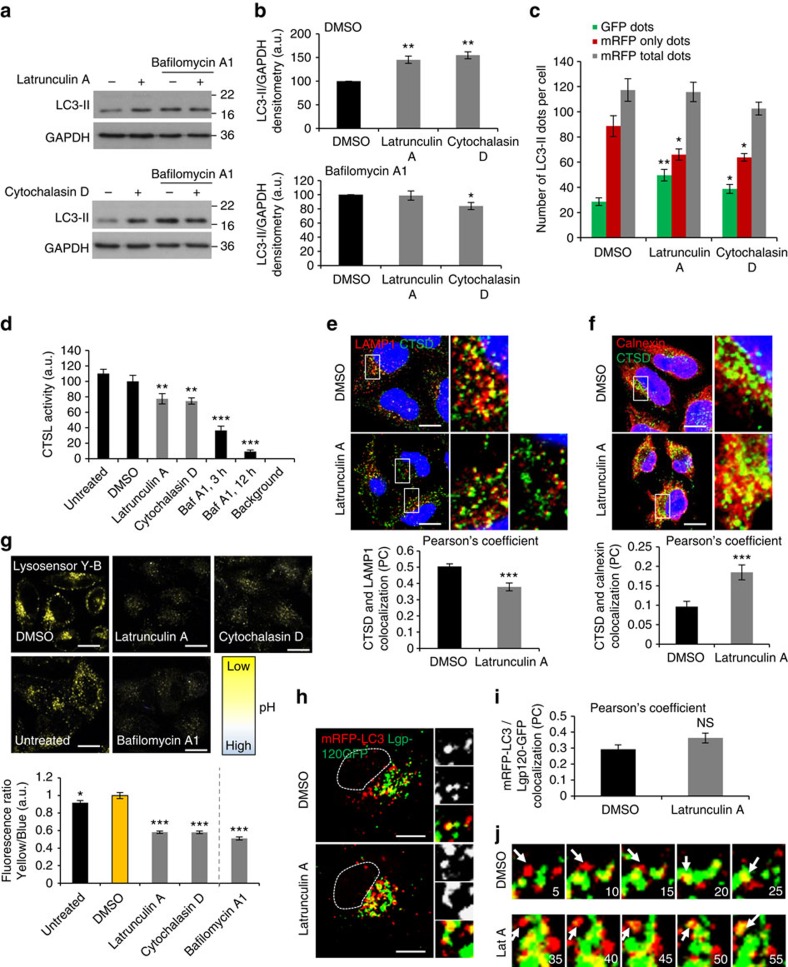
Depolymerization of actin cytoskeleton reduces the lysosomal biogenesis.(a) LC3-II levels in HeLa cells treated with latrunculin A (1 μM) or cytochalasin D (1 μM) for 3 h in the presence or absence of Bafilomycin A1 (400 nM, 3 h). (b) LC3-II/GAPDH densitometry in HeLa cells treated with Latrunculin A or Cytochalasin D as in a. Bars—means±s.d. (n=3; **P<0.01; *P<0.05; two-tailed one sample t-test). (c) GFP dot numbers (autophagosomes) and mRFP-only dots (autolysosomes) in HeLa cells stably expressing mRFP-GFP-LC3 and independently treated with 1 μM latrunculin A or cytochalasin D for 3 h. Graphs show the results for one representative experiment: eight wells of 100–200 cells each were analysed per sample. Experiment was repeated with similar results. Bars—means±s.e.m. (n=8; **P<0.01, *P<0.05; two-tailed t-test) (d) Cathepsin L (CTSL) activity in HeLa cells treated with the indicated drugs (1 μM, 3 h). Bafilomycin was positive control (400 nM, 3 h). Bars—means±s.d. (n=3; ***P<0.001, **P<0.01; two-tailed t-test). (e) Cathepsin D (CTSD, anti-mouse Alexa 488) and LAMP1 (anti-rabbit Alexa 568) double-immunostaining in cells treated with latrunculin A (1 μM, 3 h). Bottom graph—colocalization quantification. More than 30 cells were counted per experiment (each experiment was performed at least twice). Bars—mean±s.e.m. (***P<0.001; two-tailed t-test). Scale bar, 10 μm. (f) Cathepsin D (anti-mouse Alexa 488) and calnexin (anti-rabbit Alexa 568) double-immunostaining in latrunculin A-treated cells (1 μM, 3 h). Bottom panel—colocalization quantification. More than 30 cells were counted per experiment (each experiment was performed at least twice). Bars—means±s.e.m. (***P<0.001; two-tailed t-test). Scale bar—10 μm. (g) Lysosomal pH in cells treated with actin disrupting drugs (latrunculin A, cytochalasin D; 3 h, 1 μM) in full medium. Bafilomycin A1—positive control for increased lysosomal pH. More than 50 cells were counted per experiment, performed twice. Bars—means±s.e.m., where DMSO control was set up to 1 (arbitrary units) (***P<0.001, *P<0.05; two-tailed t-test). (h–j) mRFP-LC3 and Lgp120-GFP live-cell imaging in HeLa cells exposed to Latrunculin A (1 μM). Autophagosome–lysosome fusion is not affected compared with the control. Scale bar, 10 μm. (i) mRFP-LC3 and Lgp120-GFP colocalization expressed as Pearson's coefficient. More than 25 cells were counted per experiment. Bars—means±s.e.m. (NS, not significant; two-tailed t-test). (j) Autophagosome–lysosome fusion events in HeLa cells expressing mRFP-LC3 and Lgp120-GF. For both control and Latrunculin A treatment, the movies show five frames compressed per second (from a total of 70 frames, taken continuously). Arrows—fusion events. Scale bar, 10 μm.